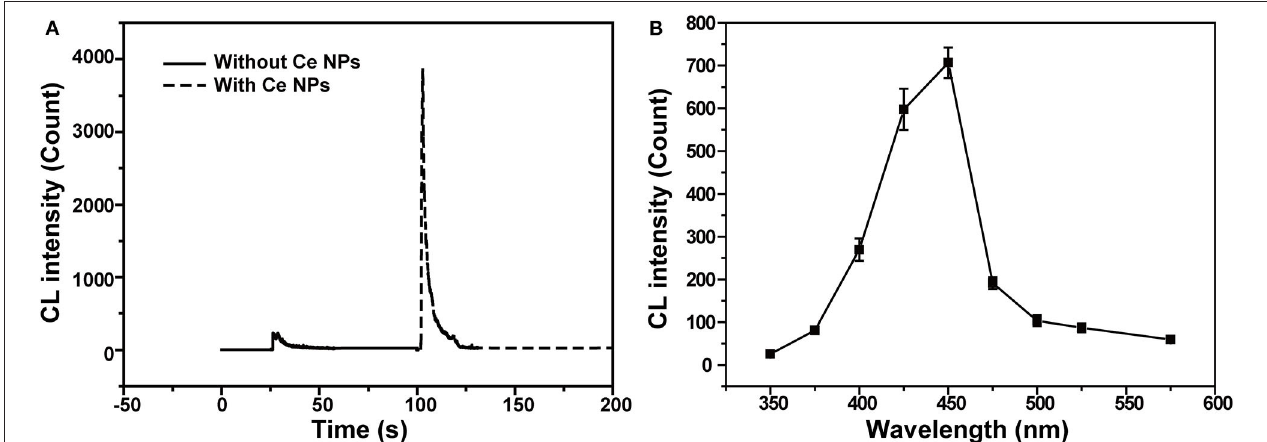
FIGURE 2 | CL profiles of the LaF 3 :Ce NPs-NaNO 2 -H 2 O 2 system. (A) Comparison of CL intensities of the NaNO 2 -H 2 O 2 system with and without LaF 3 :Ce NPs. (B) CL spectrum of the LaF 3 :Ce NPs-NaNO 2 -H 2 O 2 system. The standard error bars mean the variation of three individual experiments. Conditions: 3.00M H 2 O 2 in 0.04M H 2 SO 4 , 50 µ l of LaF 3 :Ce NPs and 10 µ M NaNO 2 solution. Voltage of the PMT was set at 1.2